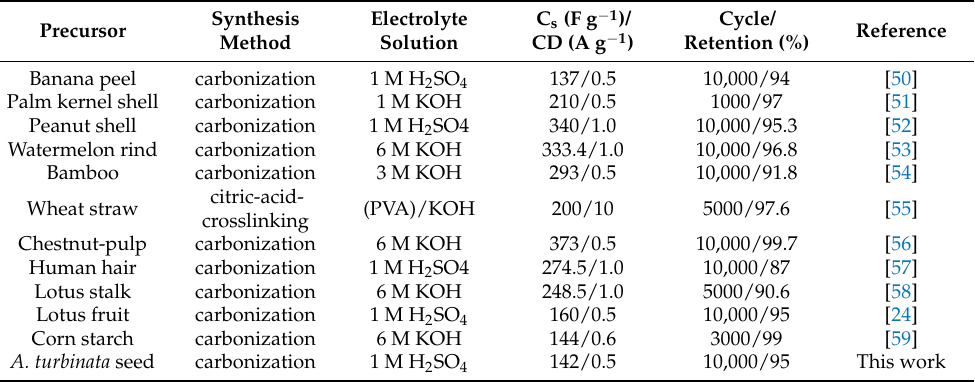
Table 1. Comparison of present work with the previously reported literature on carbon-based materials from various natural